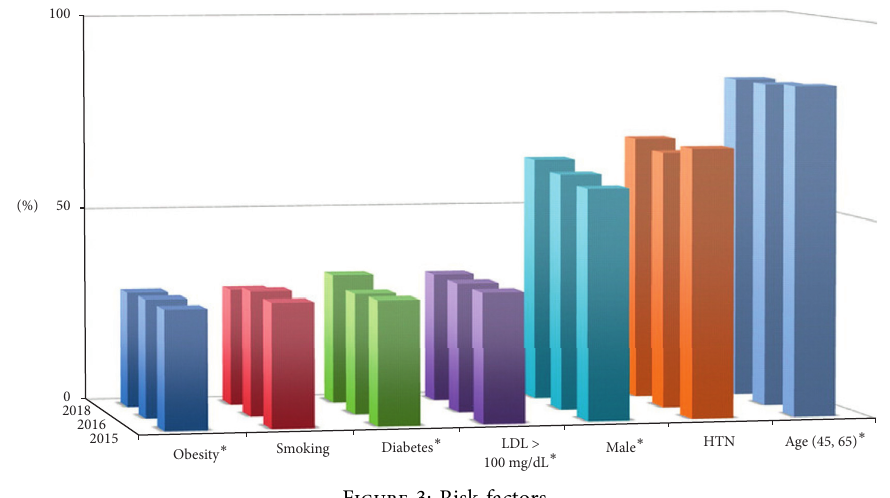
Figure 3: Risk factors.